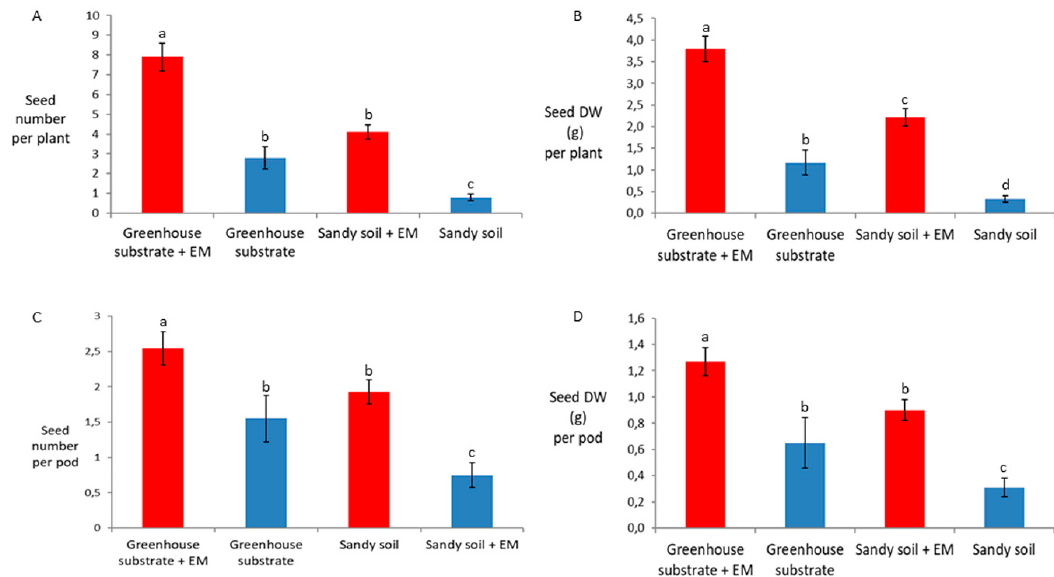
Figure 2. Seed yield. Effects of EM treatments on ( A ) seed number per plant, ( B ) seed dry weight (DW) per plant, ( C ) seed number per pod, and ( D ) seed DW per pod. Bean plants were grown on greenhouse substrate and sandy soil. Results are expressed as mean ( n = 15), and error bars indicate the SD. Significant differences were accepted at p < 0.05 and represented by different letters, according to Tukey’s HSD test.